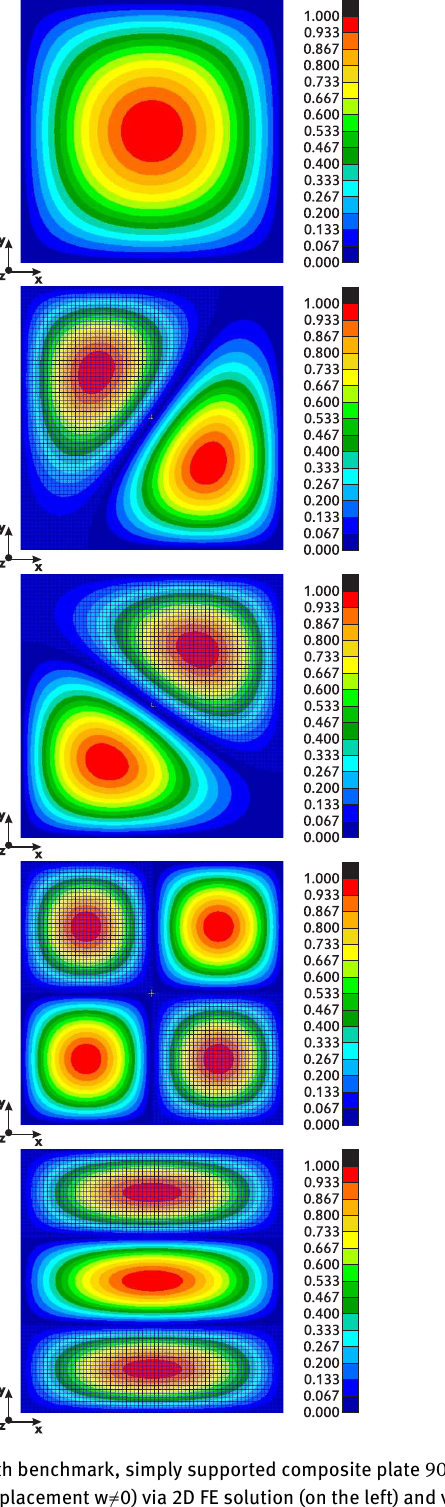
The same considerations seen in Table 18 for the sandwich plate are confirmed in Table 19 for the